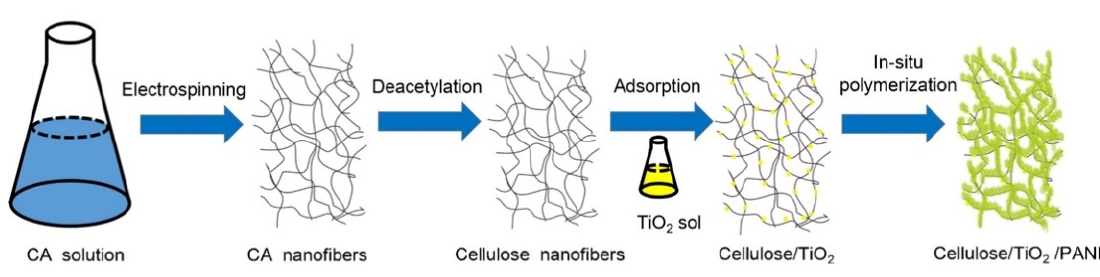
Figure 10. Production steps for CNF/TiO 2 /PANI composite. Reproduced from Ref. [116].